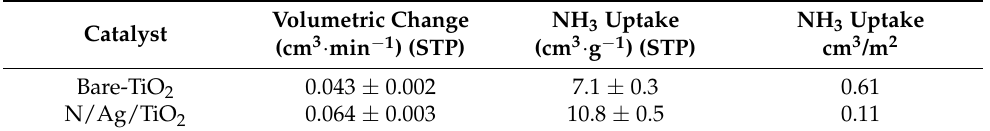
Figure 2. NH 3 -temperature-programmed desorption (TPD) profiles of the synthesized bare-TiO 2 and the N/Ag/TiO 2 photocatalysts. Table 2. NH 3 -TPD characterization of the synthesized bare-TiO 2 and N/Ag/TiO 2 photocatalysts.